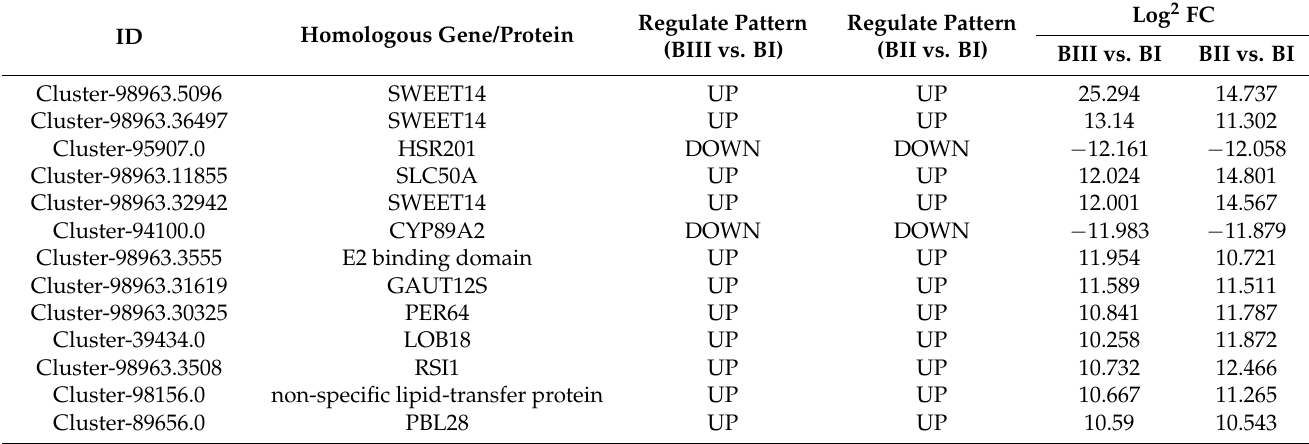
Table 1. Candidate genes selected for further study of bulblet formation mechanism based on absolute value of log 2 fold change.